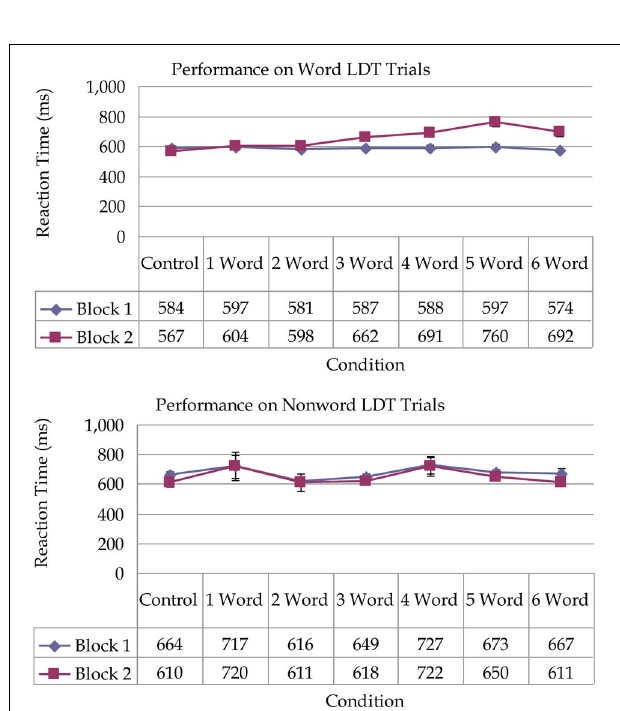
FIGURE 3 | Upper panel represents reaction time latencies measured in milliseconds on word trials in the lexical decision task as a function of condition. Lower panel represents reaction time latencies measured in milliseconds on non-word trials in the lexical decision task as a function of condition. Bars represent standard